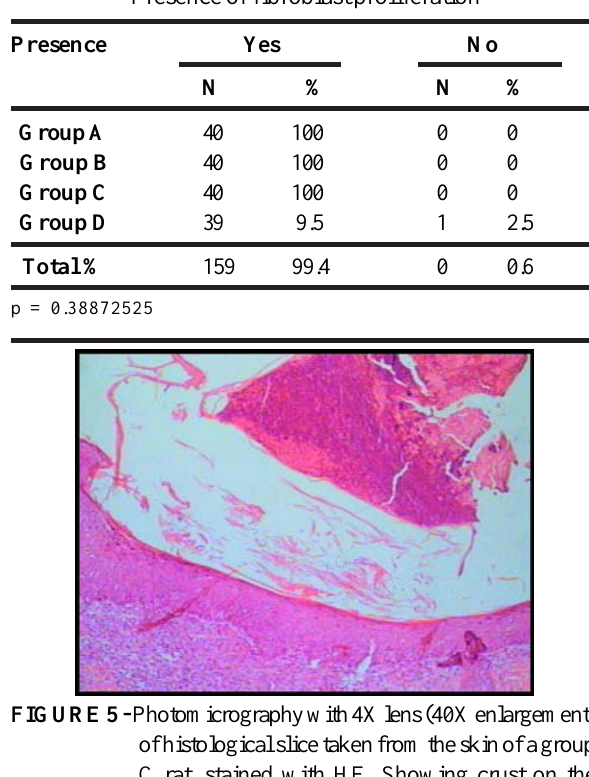
TABLE 5 - Histopathological evaluation of surgical wound. TABLE 6 - Histopathological evaluation of surgical wound.